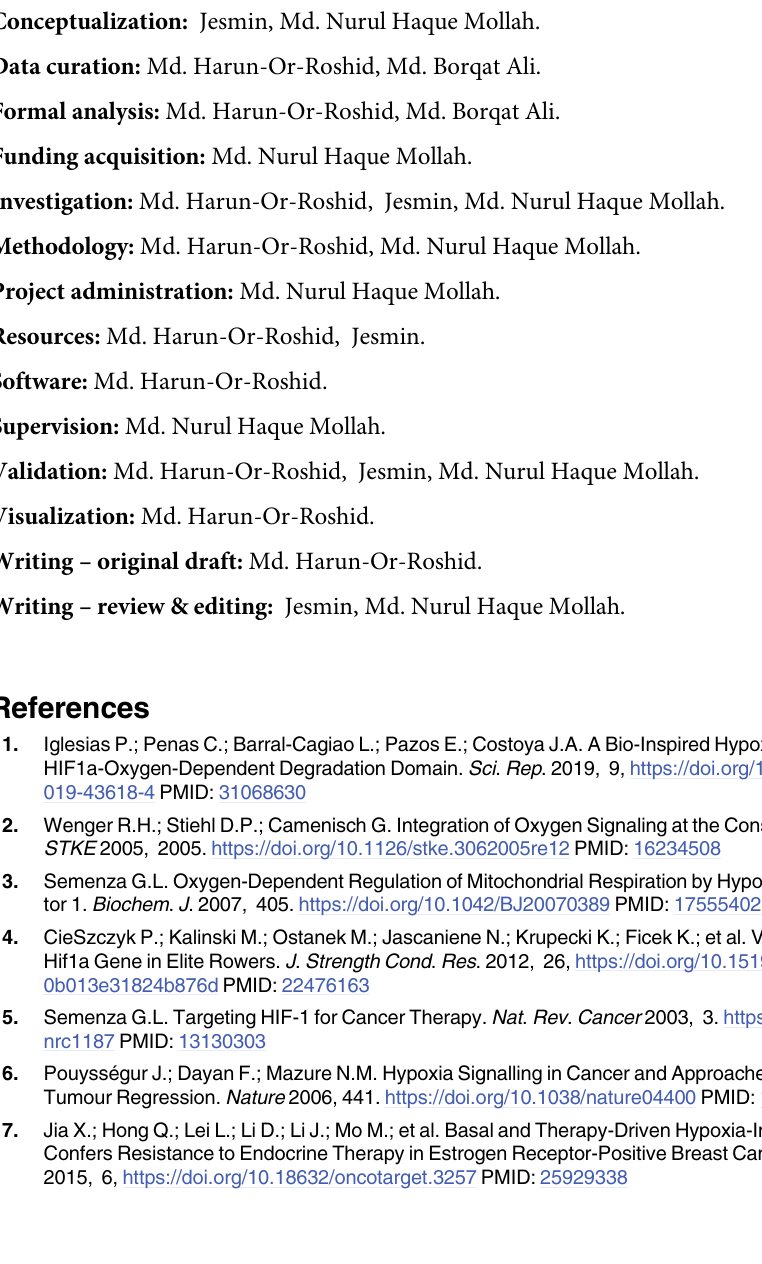
S3 Table. Publication bias checking by using Egger’s linear regression and Begg’s test of HIF1A gene polymorphisms. S4 Table. Group of disease conducting this